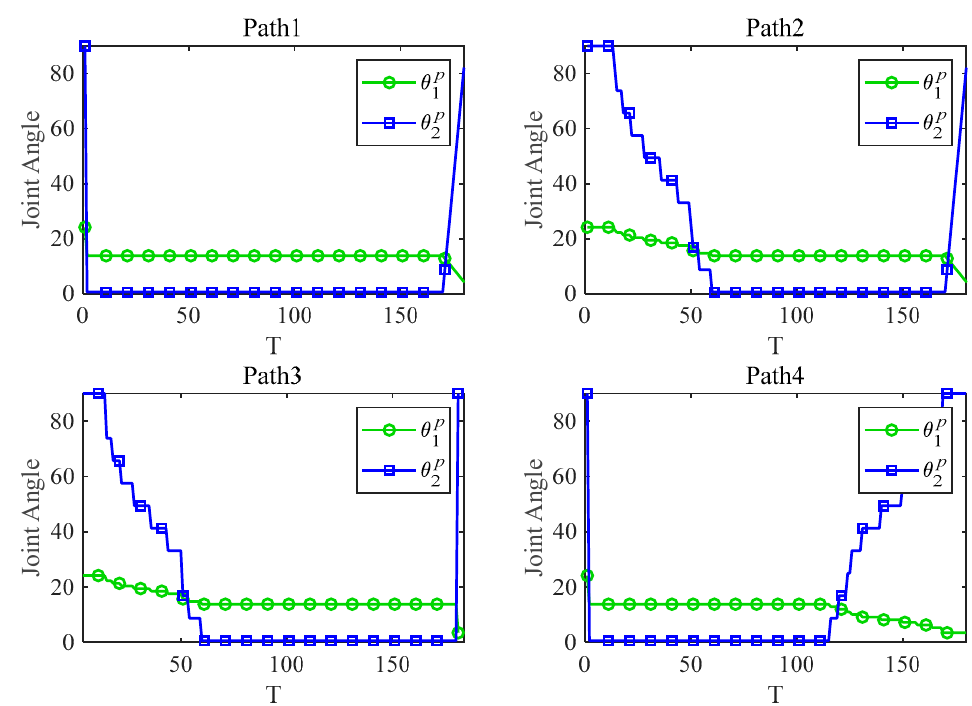
Figure 29. Angle curves of planned joints under four collision-free paths.